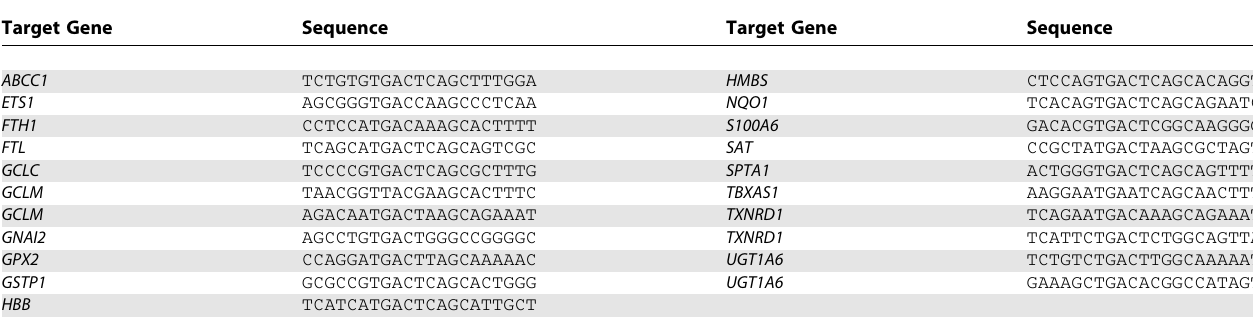
Table 2. Validated Human NRF2 TFBSs Target Gene Sequence